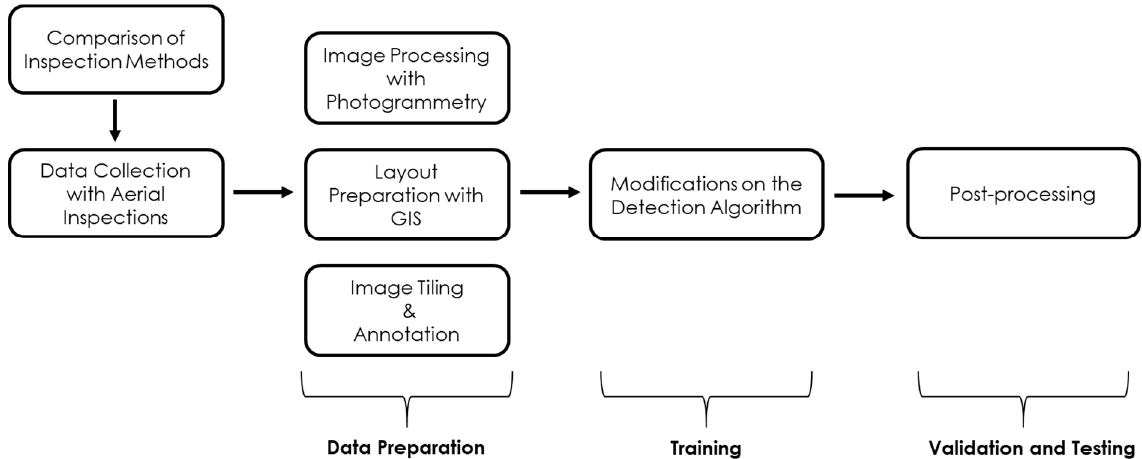
Figure 1. Flow chart of the methodology.